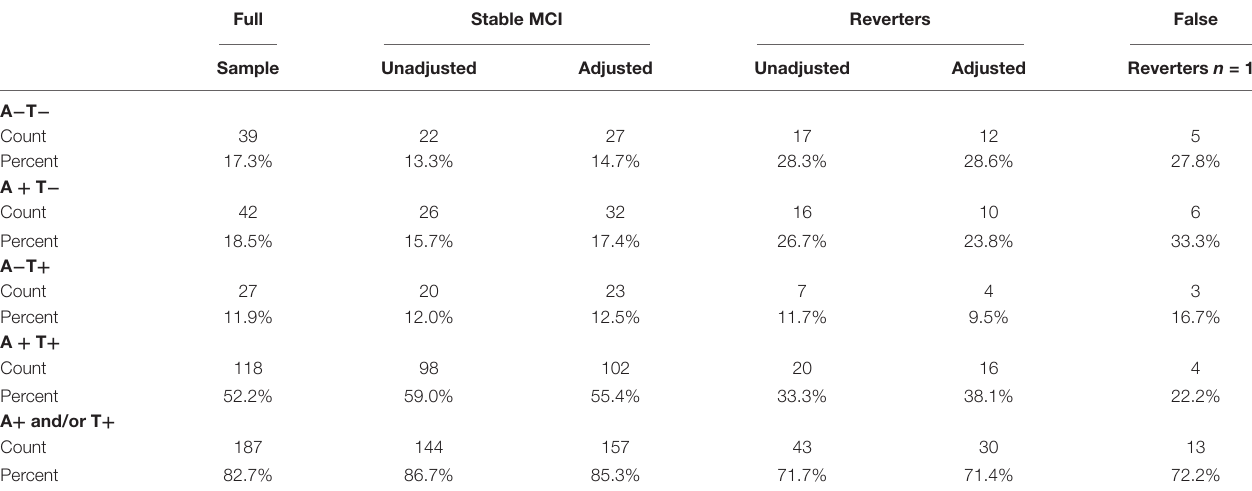
TABLE 6B | Combined amyloid and tau positivity